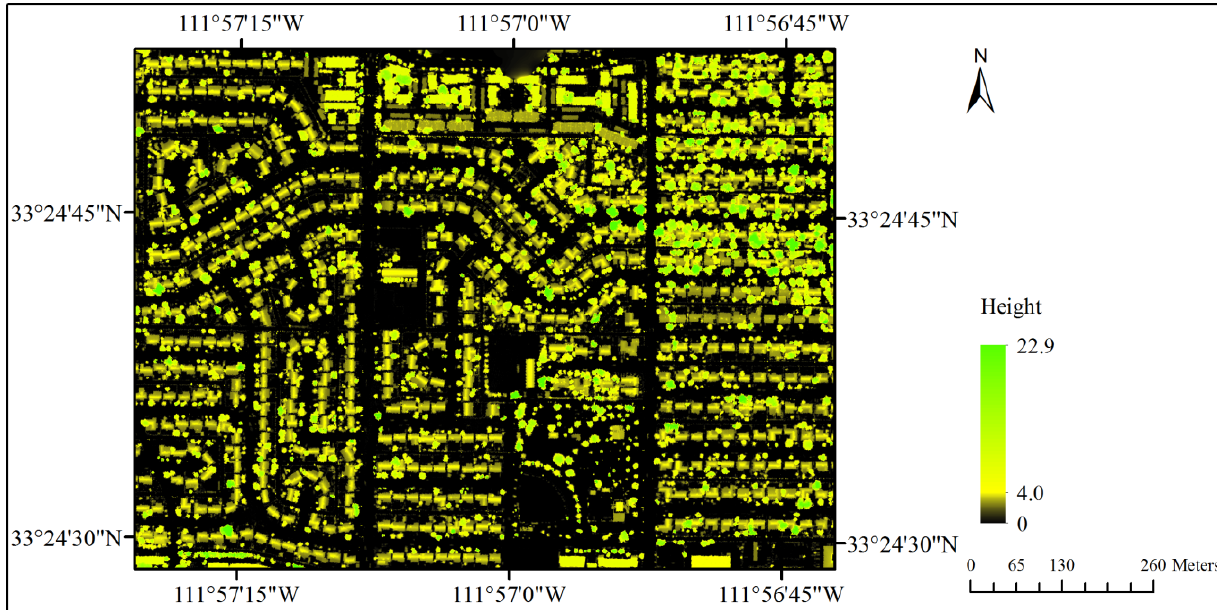
Figure 7. Normalized height surface derived by airborne LIDAR point clouds.